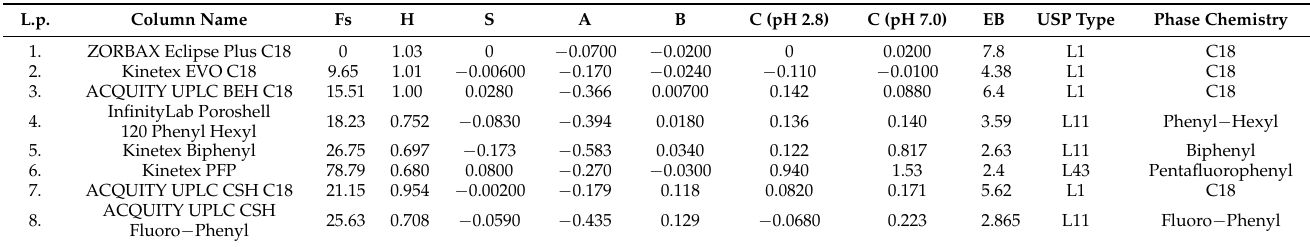
Table 2. List of the tested column and their properties: Fs—factor describes column